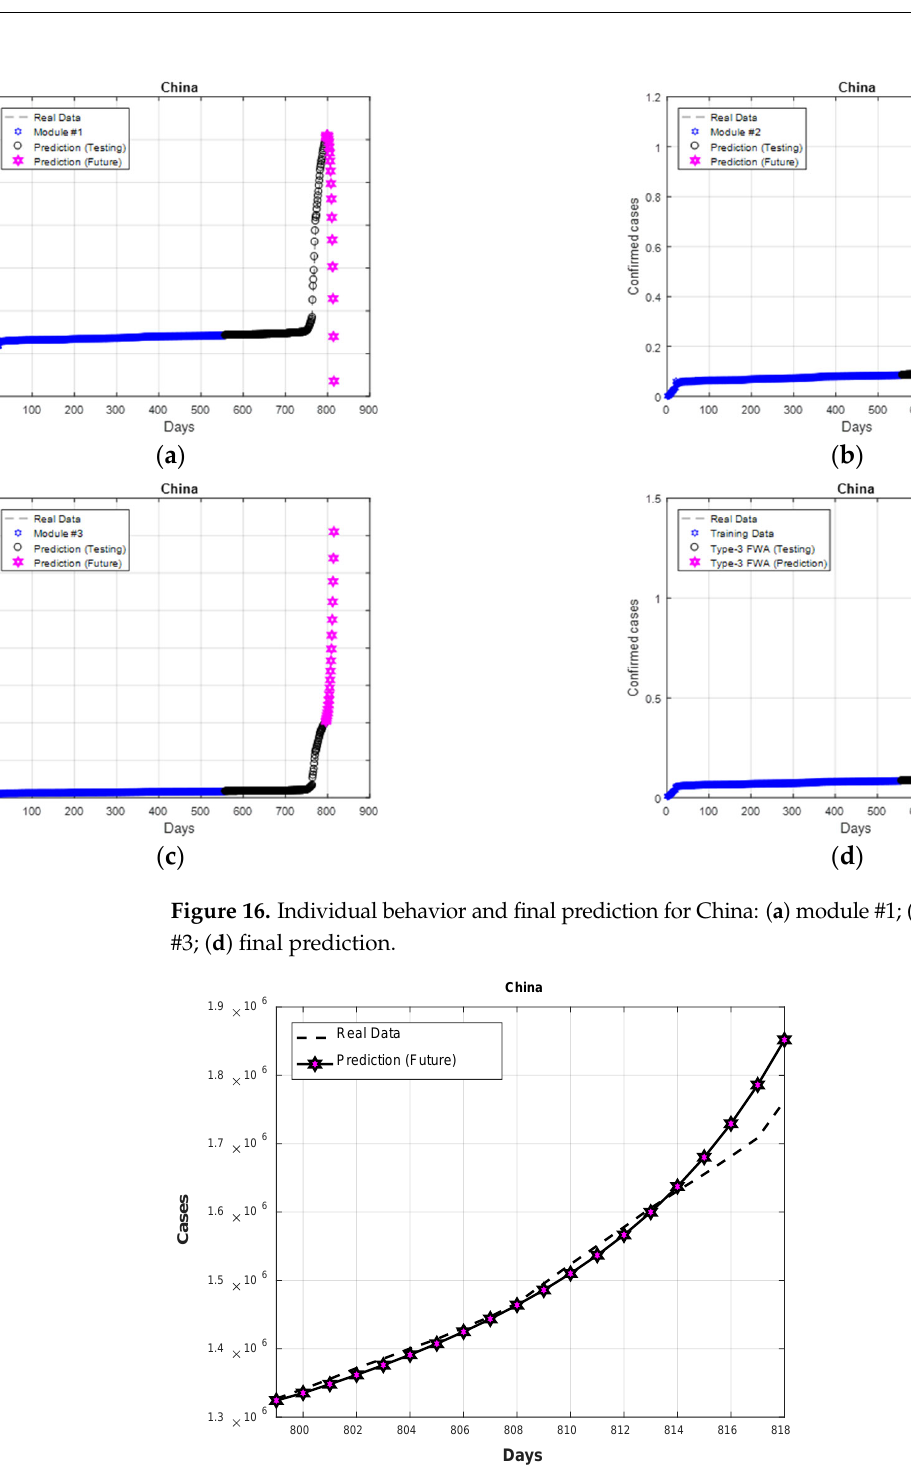
Figure 17. Best future prediction (China).